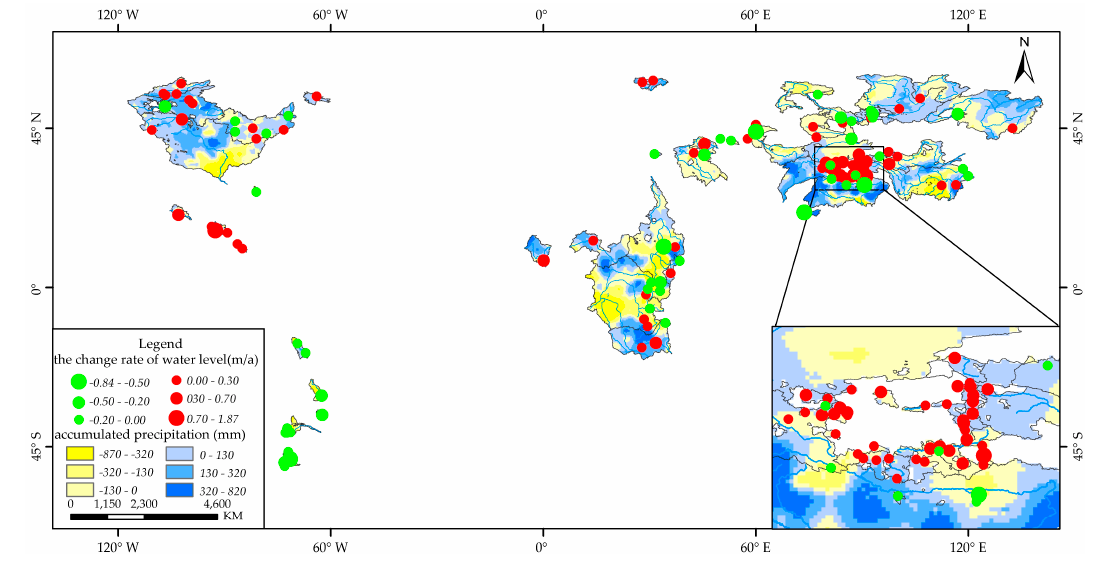
Figure 4. Accumulated precipitation and trend changes of the lake level in the watershed data.